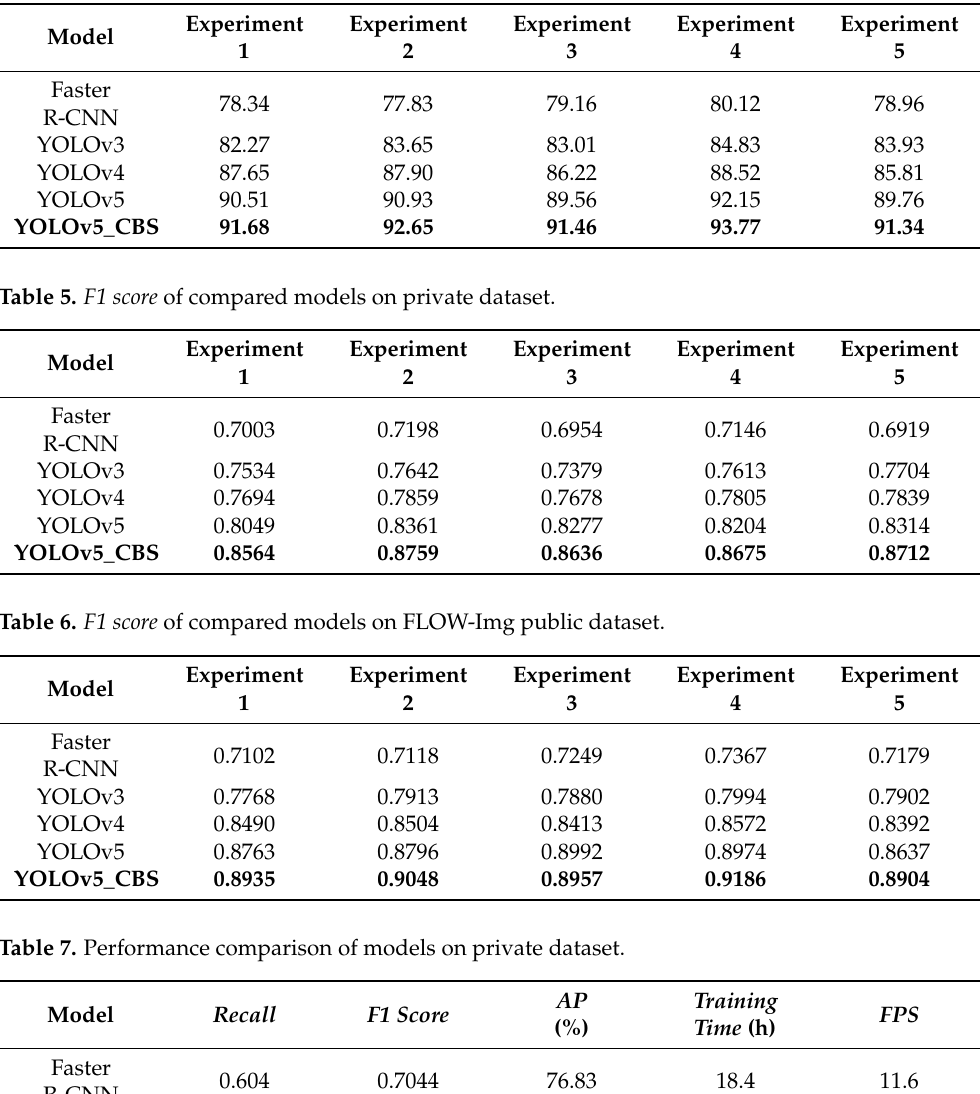
Table 4. Average precision (%) of compared models on FLOW-Img public dataset.